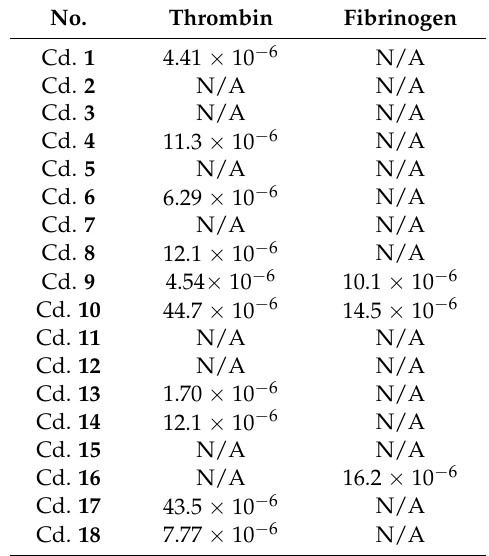
Table 8. The SPR results of phenolic acid derivatives with thrombin and fibrinogen.